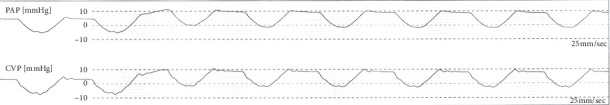
Dynamic pressure waveforms recorded by the CICC (CICCP) and TIP (TIPP) were nearly identical in the simulations of abrupt pressure changes.